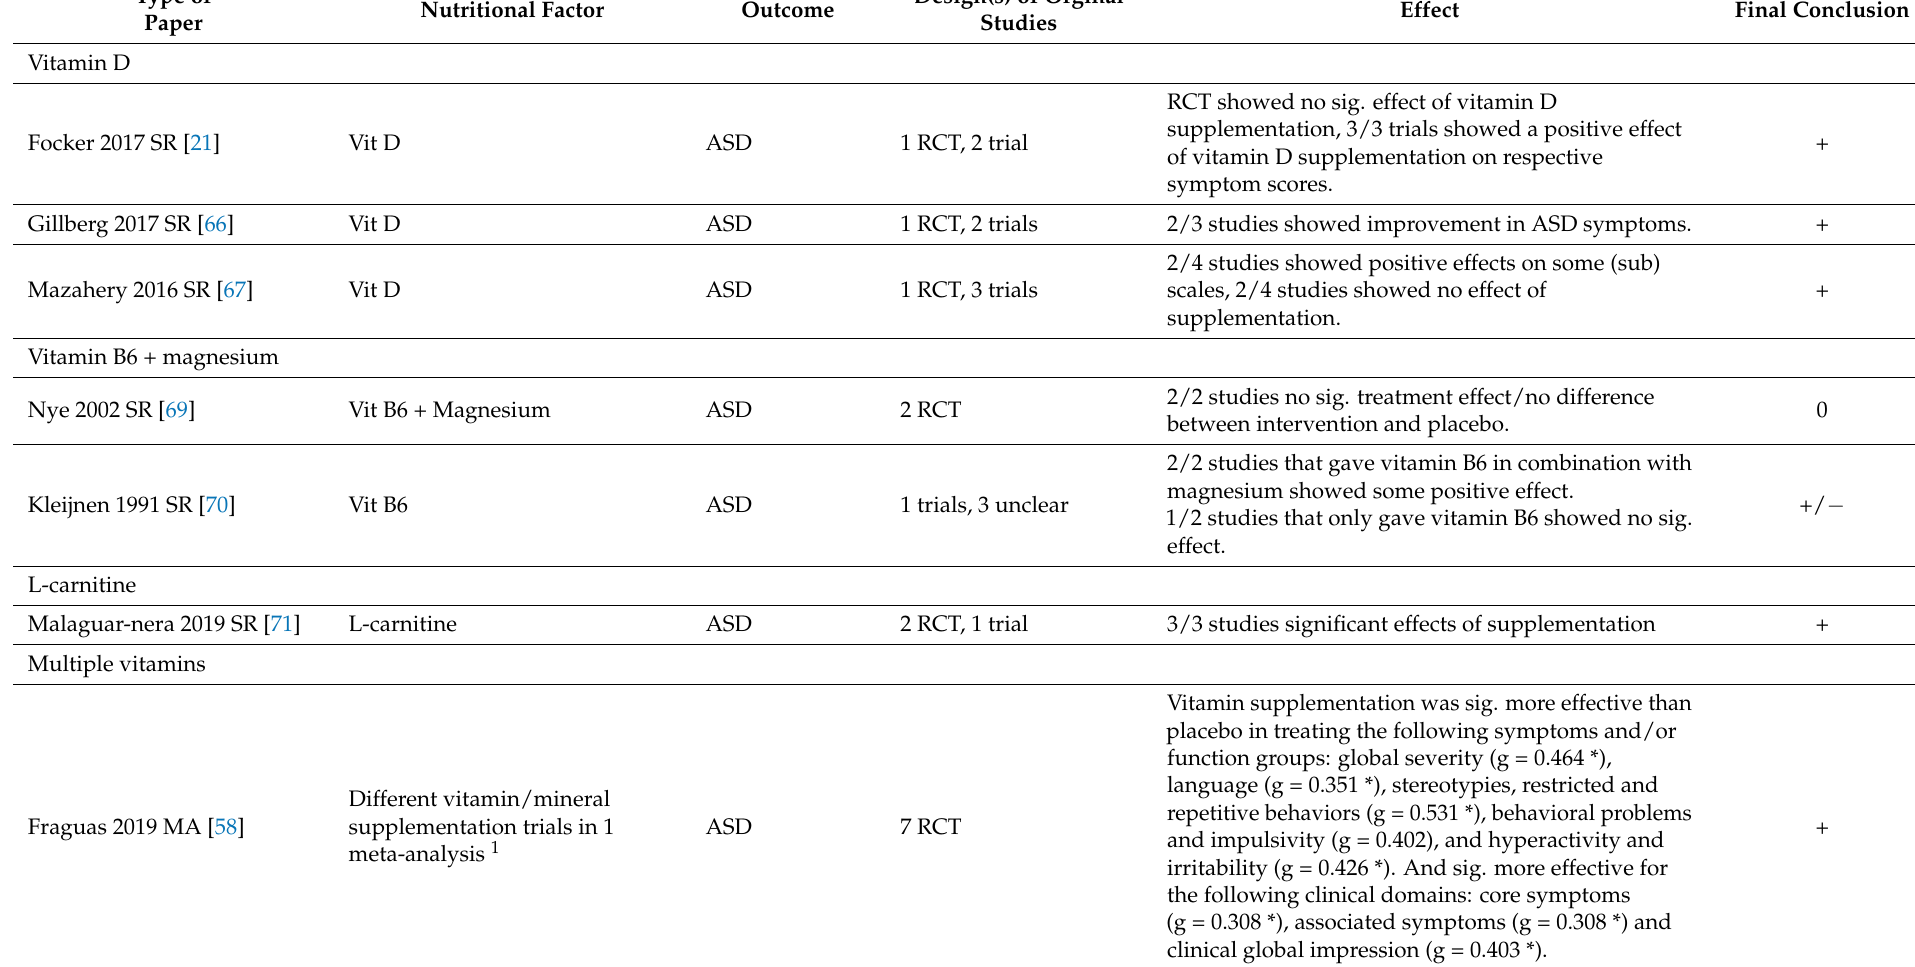
Table 6. Meta-analyses and systematic reviews concerning the relationship between vitamins and minerals, and